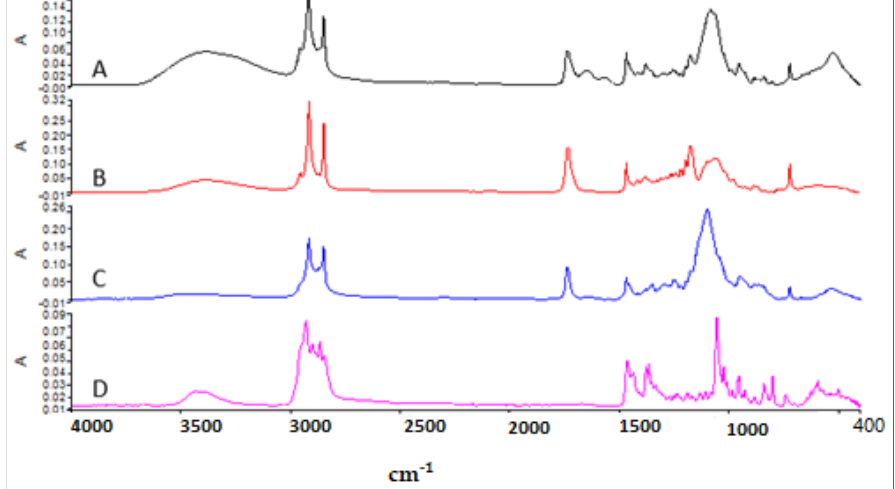
Figure 4. The FTIR spectrum of (A) blank niosome, (B) Span 60, (C) Tween 60, and (D) Chol.